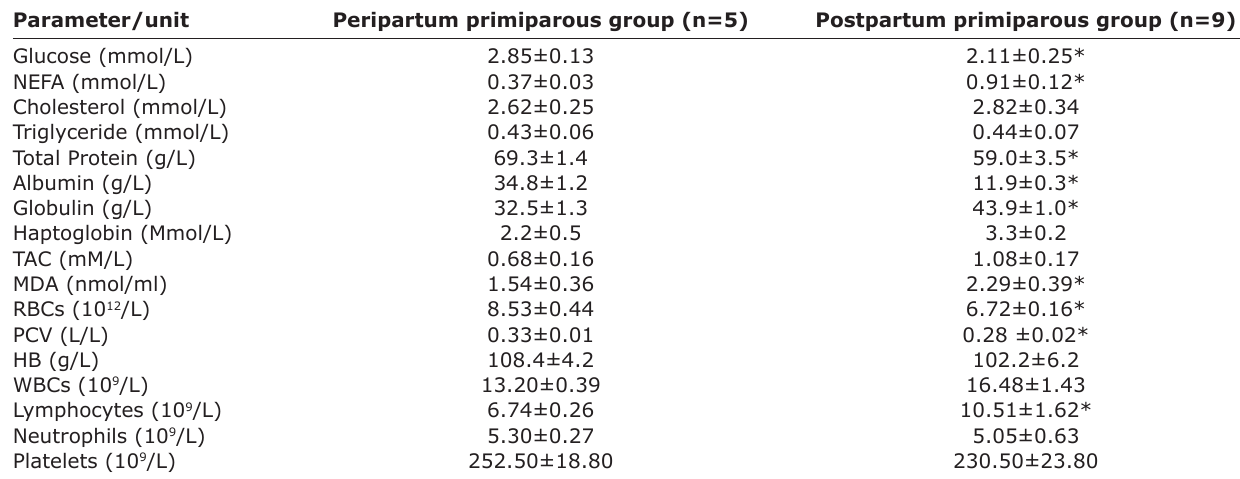
Table-1: Metabolic, oxidative stress, and hematologic profile in primiparous cows before and after parturition.